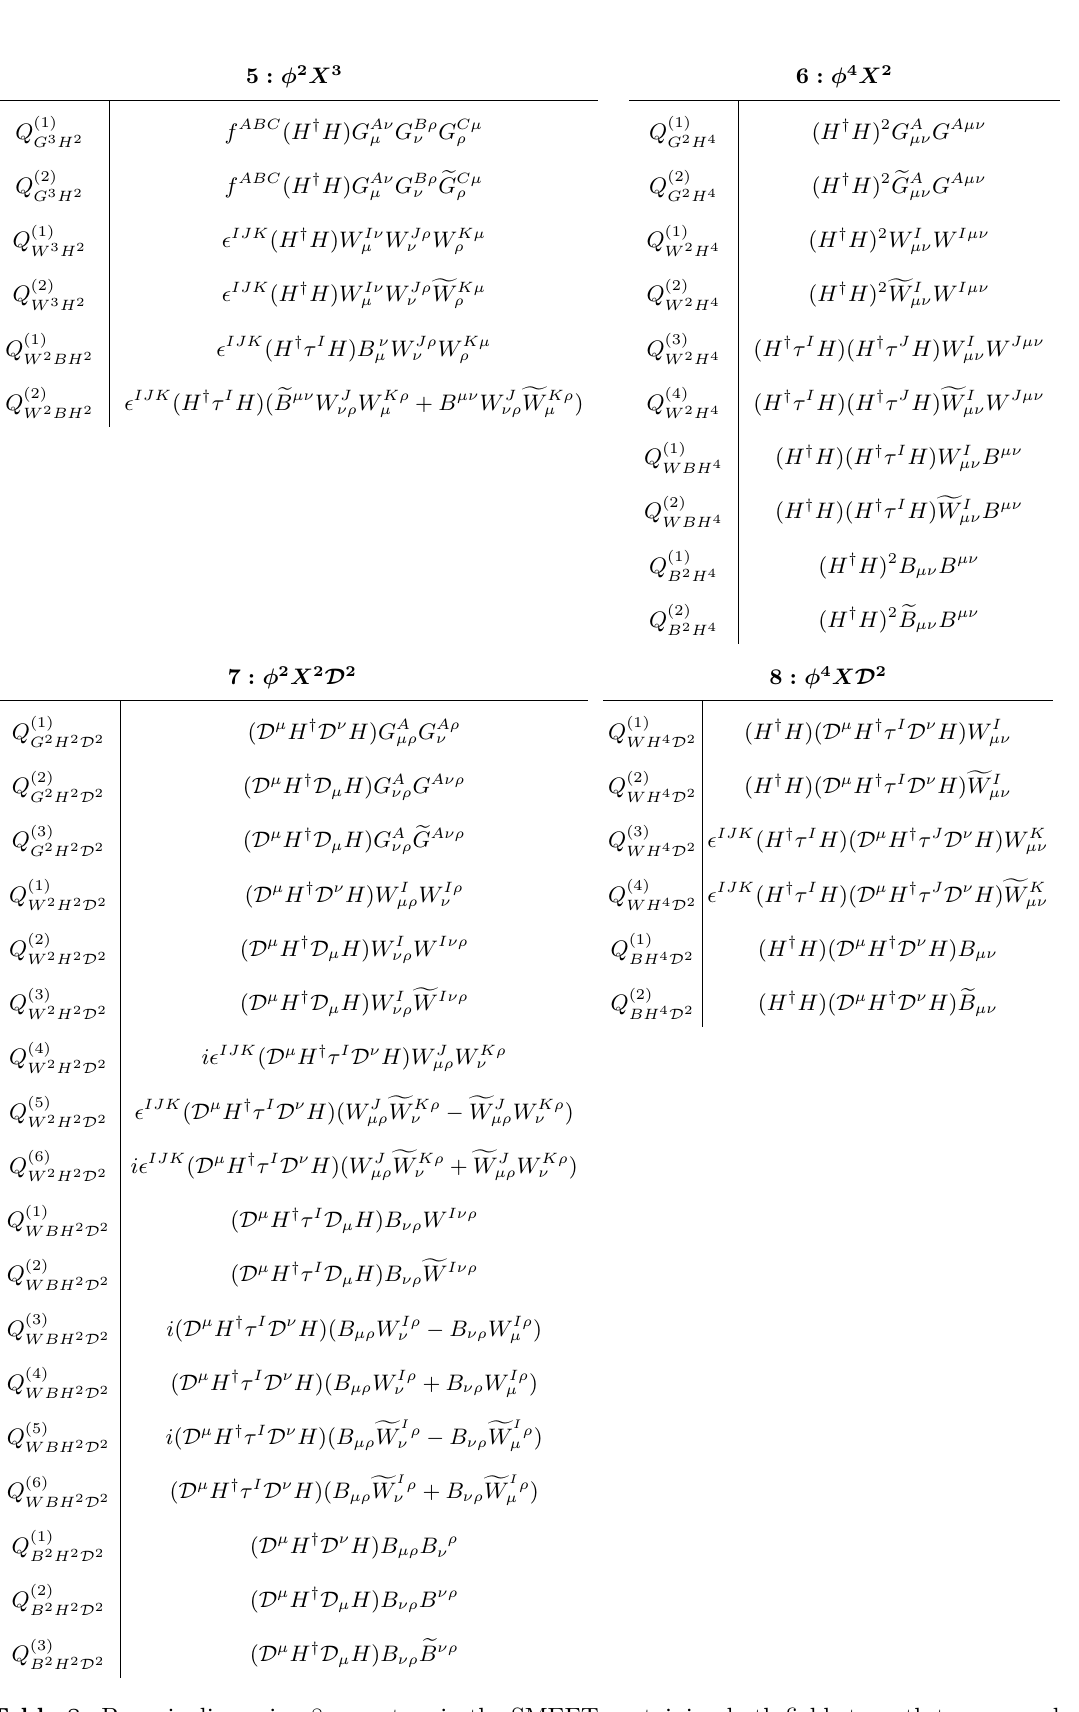
Table 8. Bosonic dimension-8 operators in the SMEFT containing both field strength tensors and Higgs boson